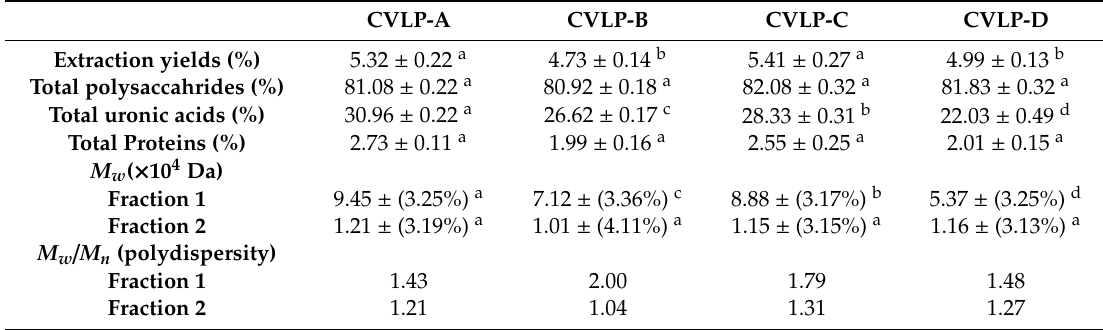
Table 2. Extraction yields, chemical compositions, molecular weights ( M w ) and polydispersities ( M w / M n ) of CVLPs. CVLP-A CVLP-B CVLP-C CVLP-D Extraction yields (%) 5.32 ± 0.22 a 4.73 ± 0.14 b 5.41 ± 0.27 a 4.99 ± 0.13 b Total polysaccahrides (%) 81.08 ± 0.22 a 80.92 ± 0.18 a 82.08 ± 0.32 a 81.83 ± 0.32 a Total uronic acids (%) 30.96 ± 0.22 a 26.62 ± 0.17 c 28.33 ± 0.31 b 22.03 ± 0.49 d Total Proteins (%) 2.73 ± 0.11 a 1.99 ± 0.16 a Fraction 1 M w / M n (polydispersity) Fraction 1 1.43 2.00 1.48 Fraction 2 1.21 1.04